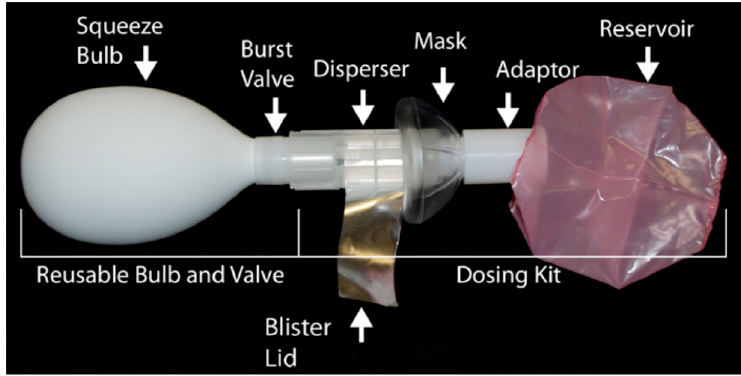
Figure 1. Design and use of the PuffHaler dry-powder inhaler [38].